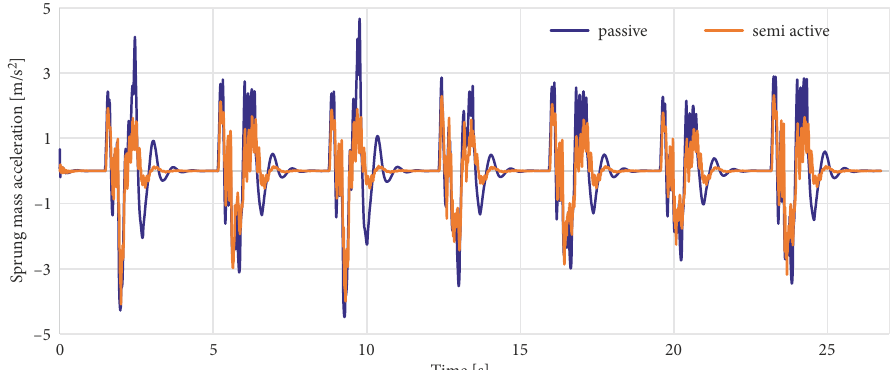
Figure 4. A suspension performance on trapezoidal road bumps, longitudinal vehicle velocity (40 km/h)